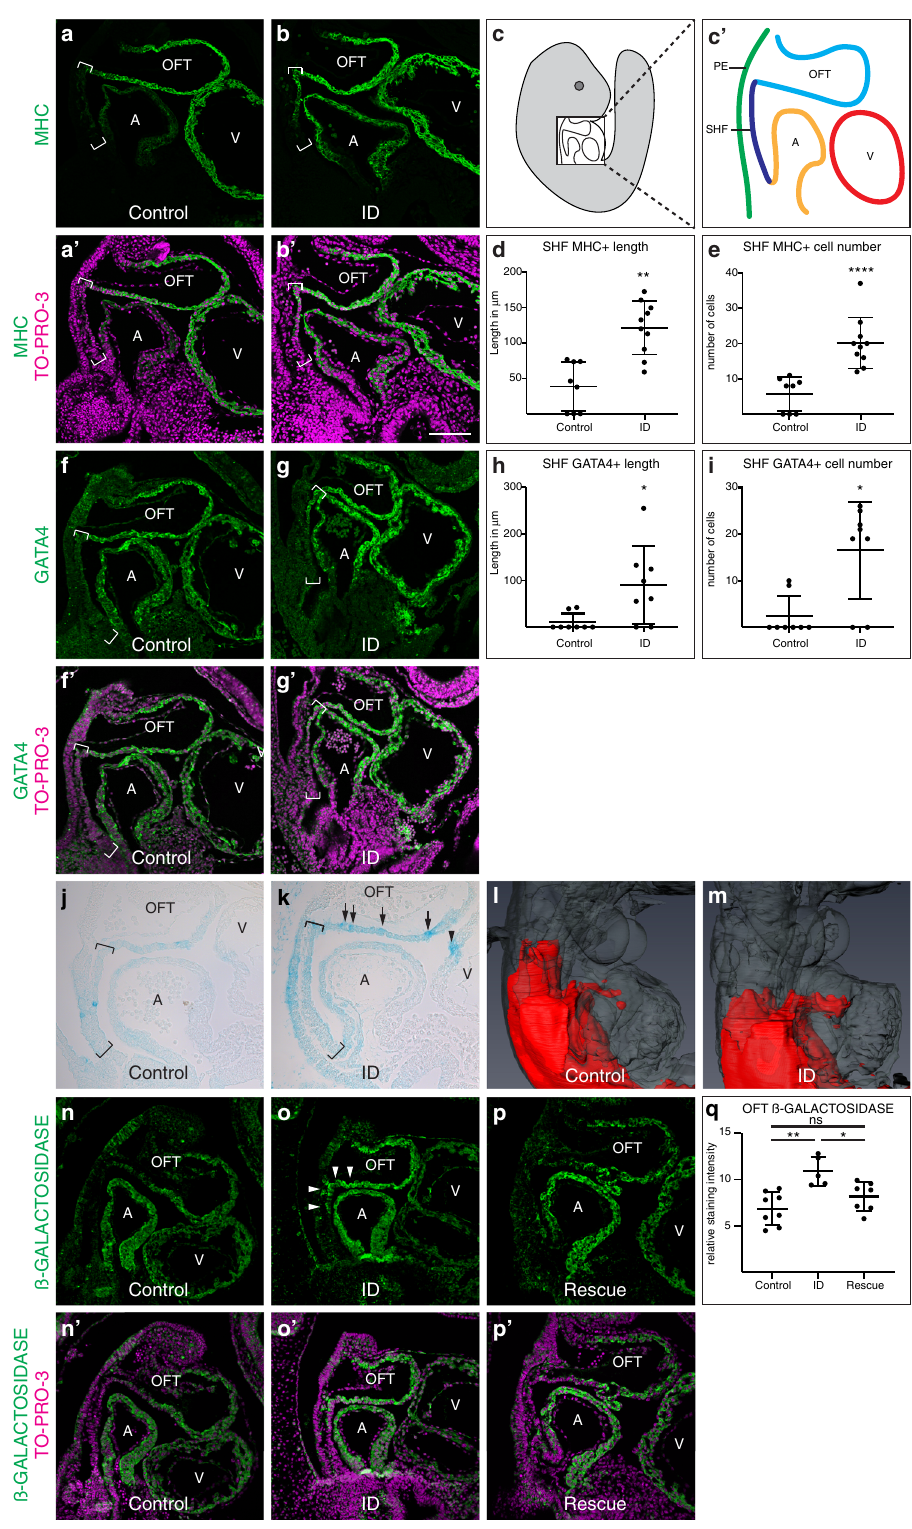
antibodies 54 (Fig. 5a, b). Lymphatic vessels in ID embryos had signi fi cantly increased in vessel diameter ( P = 0.0006, Fig. 5c) and the vessels had more PROX1-positive nuclei (compare Fig. 5 panels a ” and b ” ). The degree of increase in lymphatic vessel diameter (33 to >52 μ m) was similar to other mouse models with perturbed lymphatic development 42,55 . By contrast, inter-vessel distance was not signi fi cantly altered ( P = 0.5299, Fig. 5d),